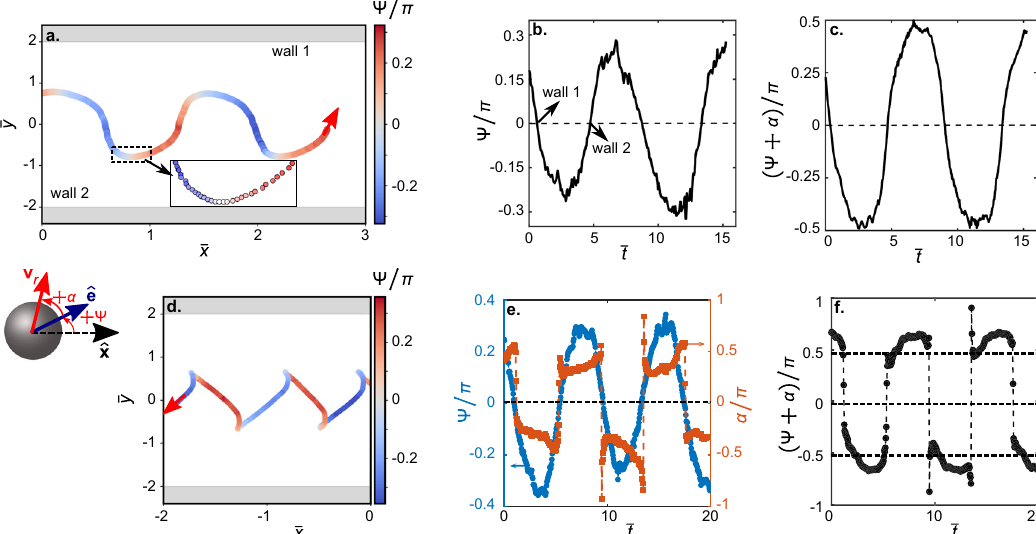
Fig. 3 Intrinsic and rheotactic droplet orientations during upstream rheotaxis and downstream drift. a Variation in the intrinsic orientation angle Ψ of the active droplet over the oscillatory rheotactic trajectory for (cid:2) u a f ¼ 0 : 42. Ψ is de fi ned as the angle between droplet orientation ^ e and horizontal ^ x unit vectors (see schematic), with positive Ψ representing anti-clockwise orientation about þ ^ x . The uncertainty in the measurement of Ψ is ≈ 11%. b Periodic variation in Ψ with the non-dimensional time ð (cid:2) t Þ during upstream rheotaxis. c Variation in the orientation of the rheotactic/tracked velocity vector v r (see schematic) relative to þ ^ x , as given by ( α + Ψ ), with (cid:2) t . d Variation in Ψ over the swinging trajectory during downstream drift of the active droplet. e Variations in Ψ and α , and ( f ) variation in ( α + Ψ ) with (cid:2) t during the downstream drift. Note that the active droplet is always oriented upstream ( ∣ Ψ ∣ / π < 0.5), even as it drifts